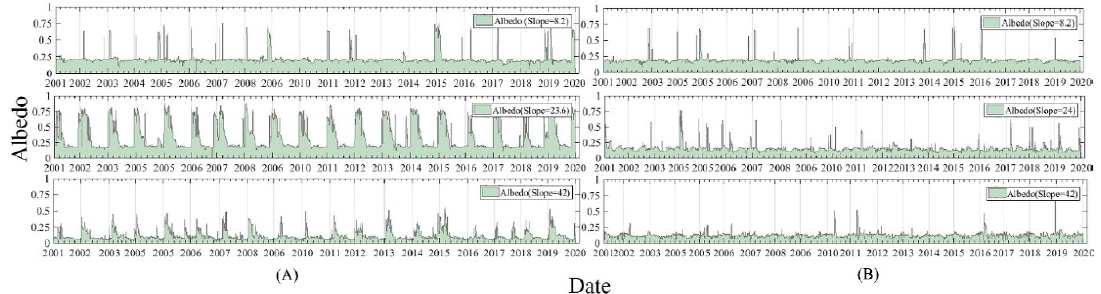
Figure 7. Surface albedo variation following the increasing of the slope at the grassland surface over mountain terrain over the years 2001 to 2019. ( A ) were located at the surface with the north aspect; ( B ) were located at the surface with the south aspect.